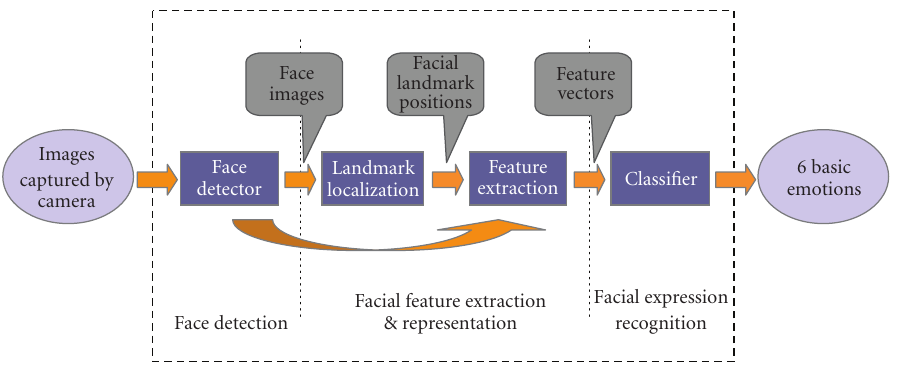
Figure 1: The proposed system for MOGs.